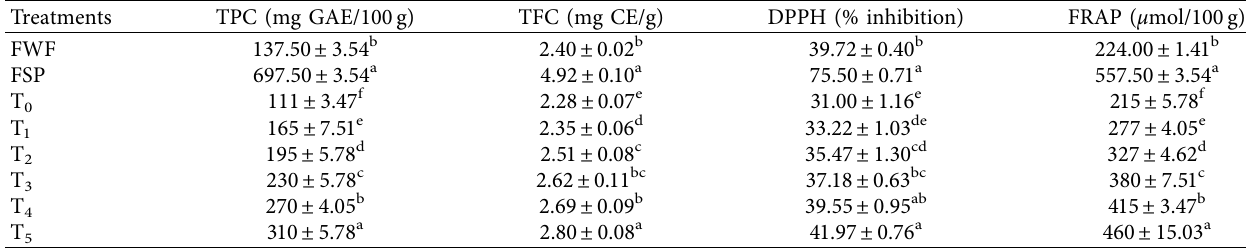
Table 4: Antioxidant activities of fenugreek seed powder (FSP) supplemented composite noodles.